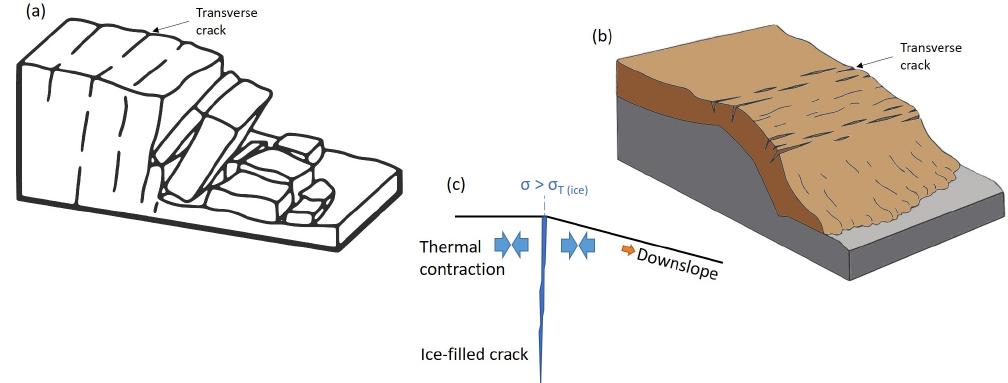
Figure 14. Mass movements such as (a) erosional scarps and (b) frozen-debris/solifluction flows initiate transverse cracks/fissures which become infiltrated by water that freezes to ice. (c) Thermal contraction of the surrounding ground and downslope gravitational stress causes the ice to crack under tension when the stress, σ , exceeds the tensile strength of ice, σ T ( ice )